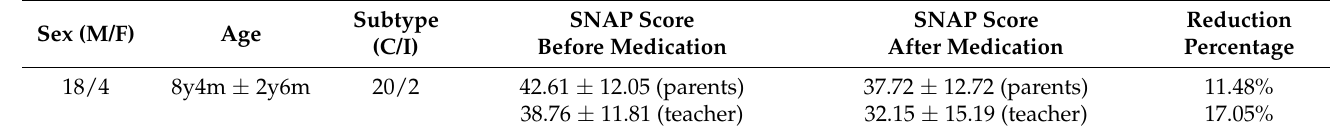
Table 1. Demographic data of patients with ADHD.